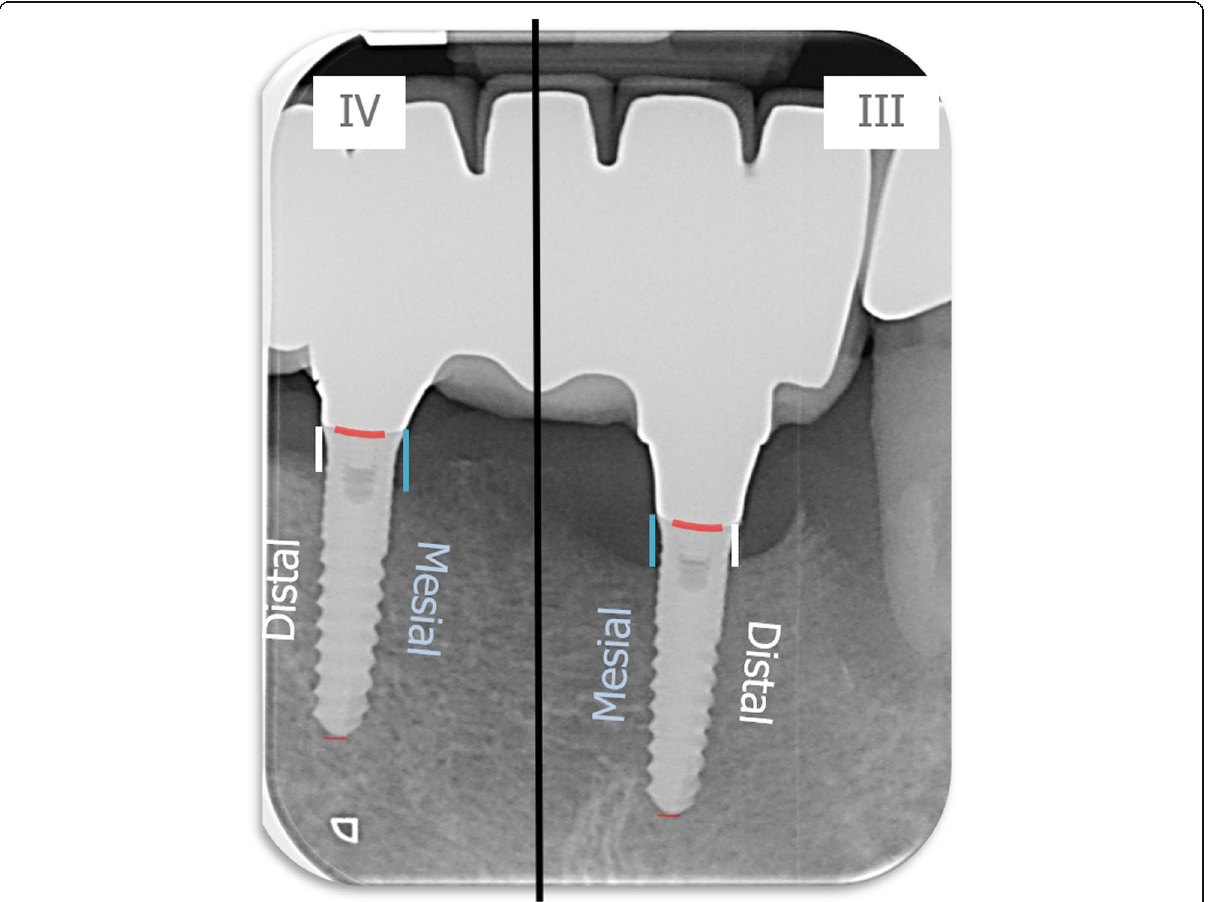
Fig. 3 Radiological measurement of crestal bone